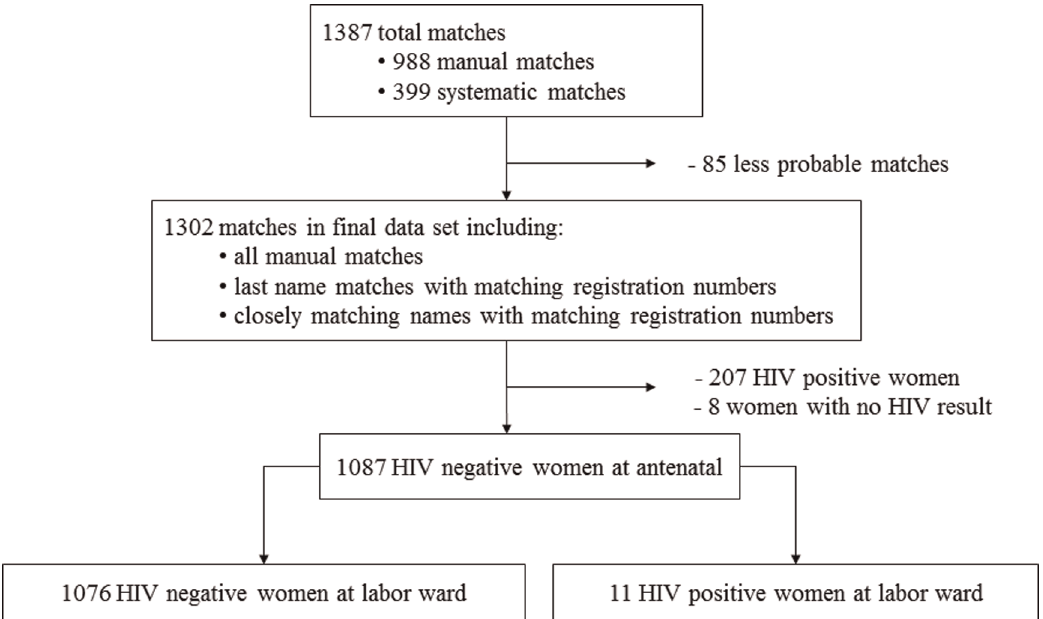
Figure 1. Matching schematic for HIV incidence calculation in the antenatal population at Bwaila Hospital. Antenatal and labor ward records were matched manually and systematically resulting in 1302 final matches whose antenatal and labor ward HIV test results were compared. Of 1087 HIV negative women at the initial antenatal test, 11 tested HIV positive at the labor ward indicating a seroconversion risk of 1% during pregnancy.